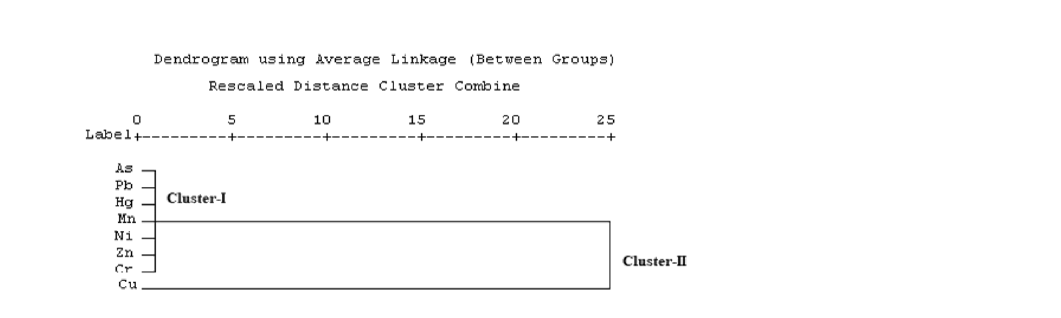
Figure 7. Clustering of heavy metals in river sand